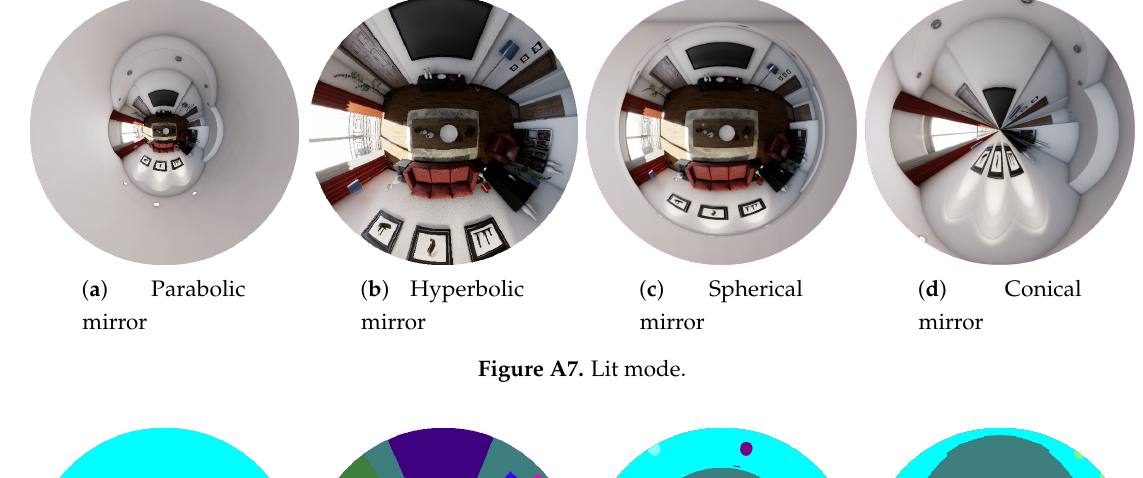
Figure A7. Lit mode.